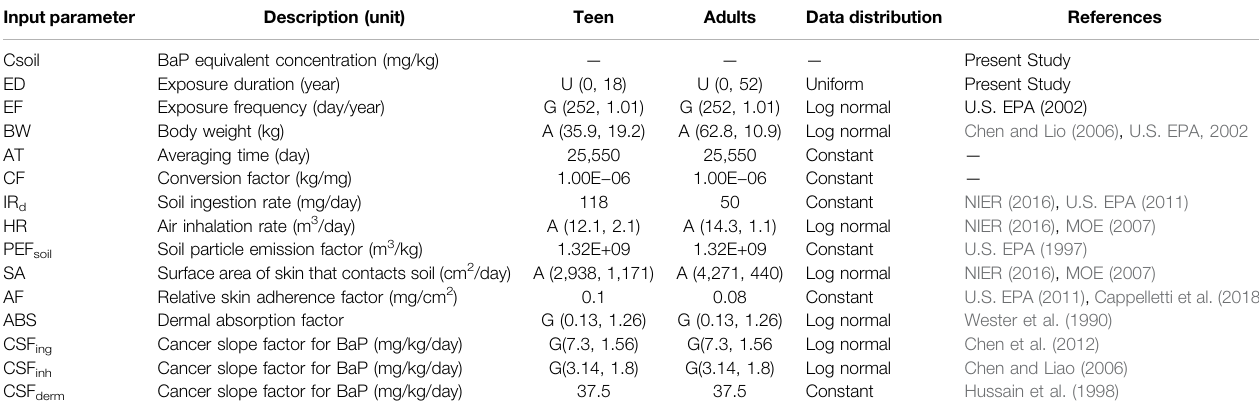
TABLE 2 | Cancer risk (CR) assessment parameters.